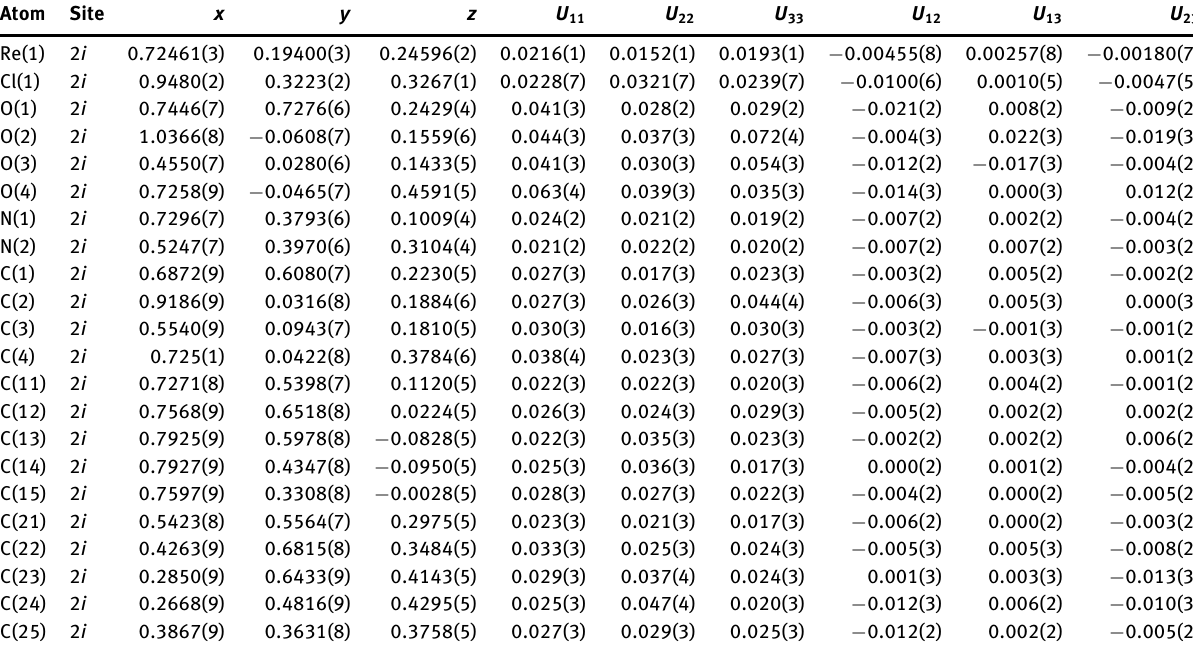
Table 3: Atomic coordinates and displacement parameters (in Å 2